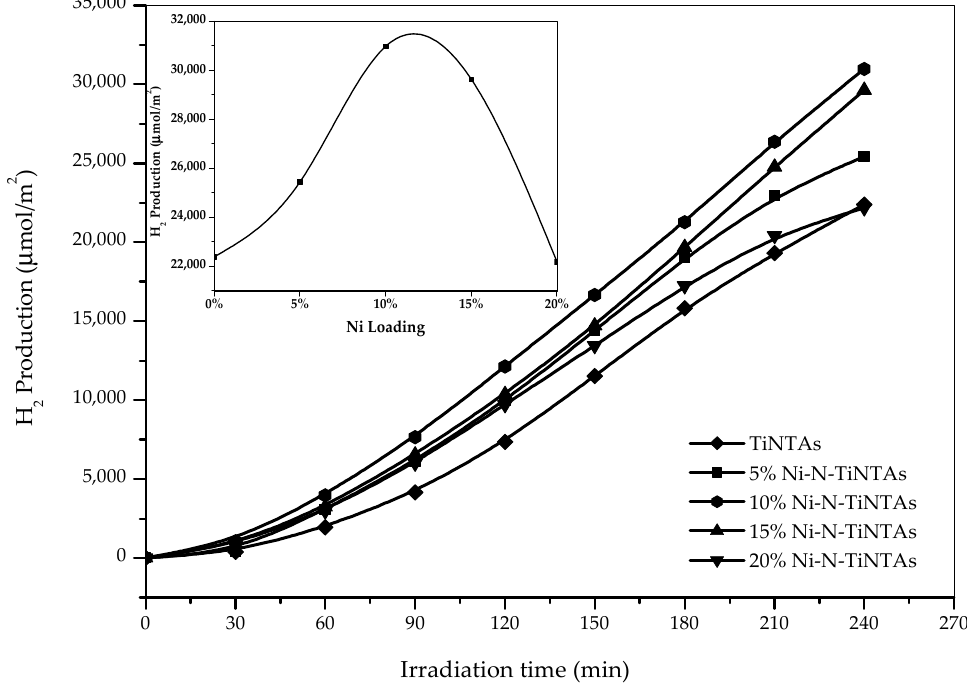
Figure 10. Effect of Ni loading on H 2 Production from glycerol–water mixture (10%v glycerol). Figure 10. E ff ect of Ni loading on H 2 Production from glycerol–water mixture (10%v